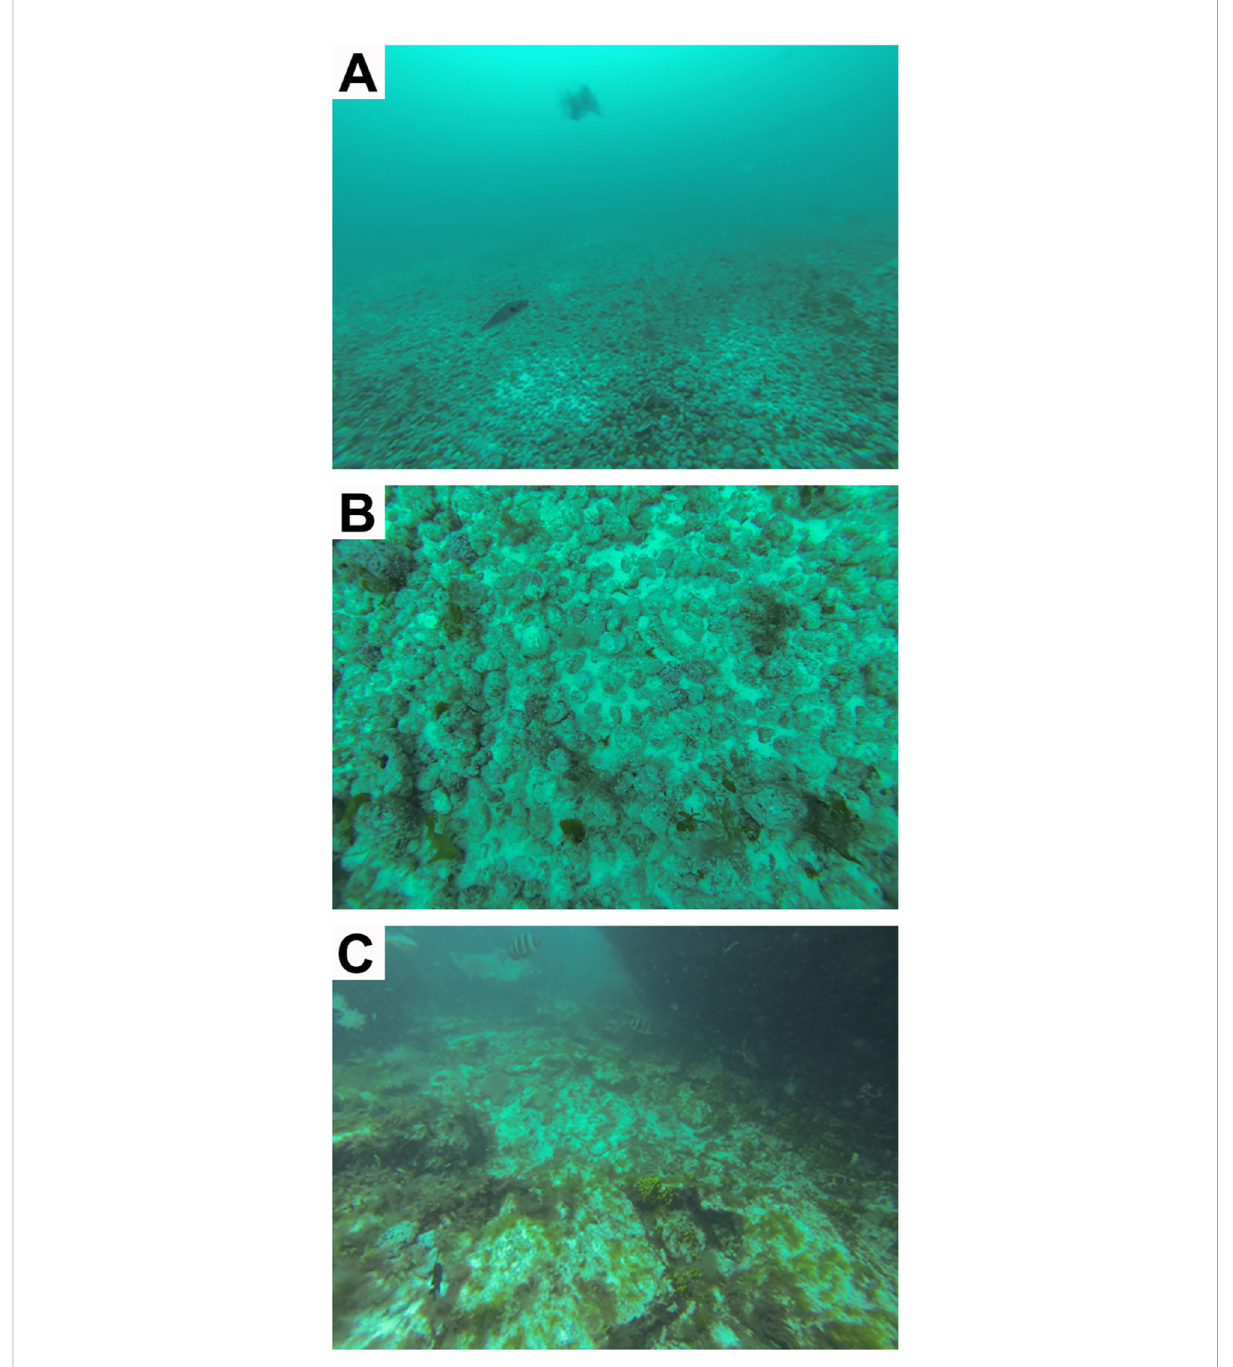
FIGURE 2 Images acquired by scuba diving. (A) RB over a sandy sea bottom at Calamareo, (B) detail of the RB at Calamareo, (C) rocky sea bottom at El Puente without any visible